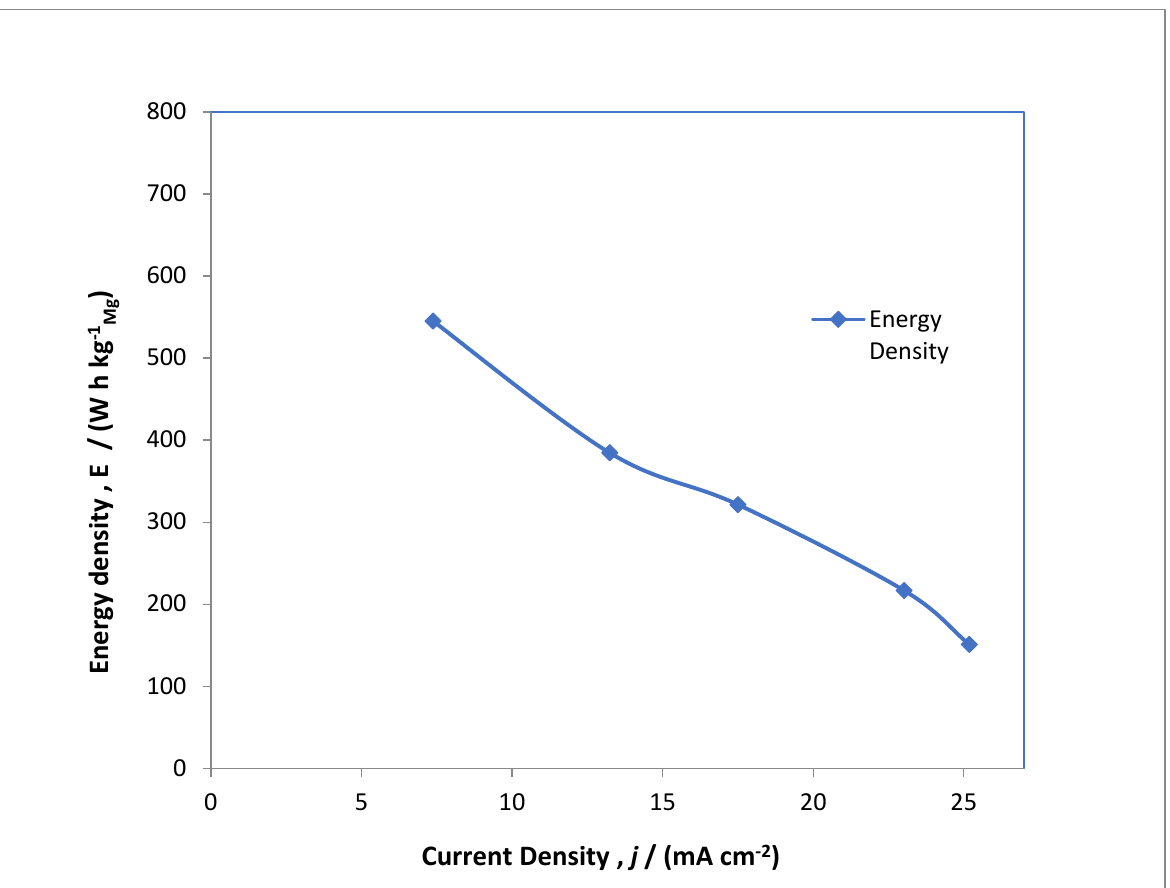
Figure 5. Cycling for discharge profile of the MAB after cycling at 17 mA cm − 2 for 17 h at 7, 13, 17, 23 and 25 mA cm − 2 current densities with an air inlet flow of 0.5 dm 3 min − 1 .